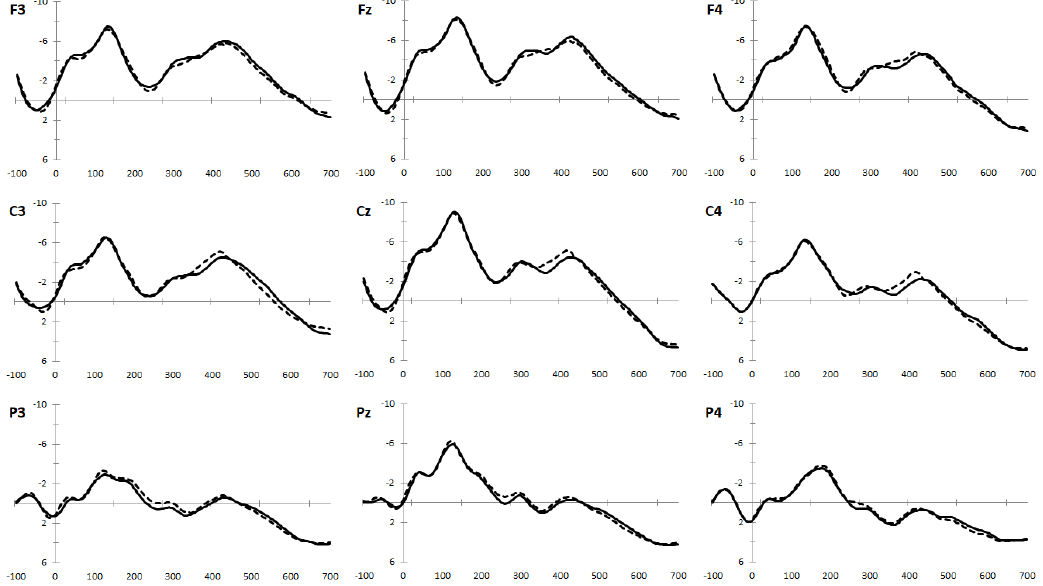
Figure 4. Grand average ERP waveforms for form-unrelated (dotted lines) and form-related words (solid lines) in Experiment 2. ERPs are plotted for nine equidistant representative electrodes within each region of interest. Negative voltage is plotted up. Onset of the Spanish word (i.e., the target) is indicated by the vertical calibration bar. Data are plotted from 100 ms prior to and 700 post stimulus onset.